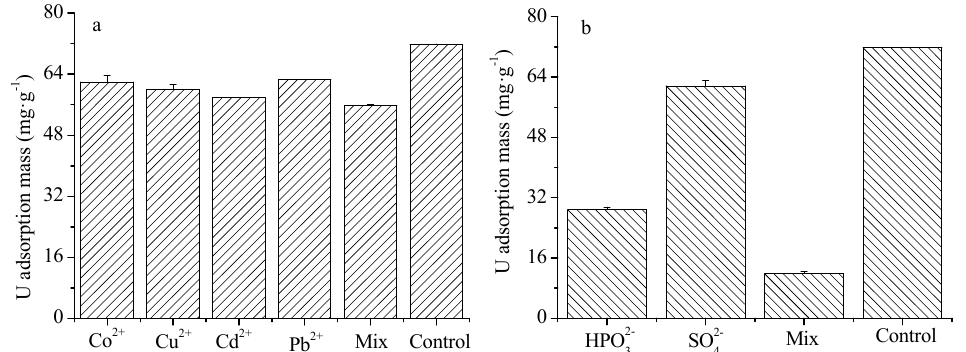
precipitation between UO 22 adsorbed onto HA surface [48,50–52].